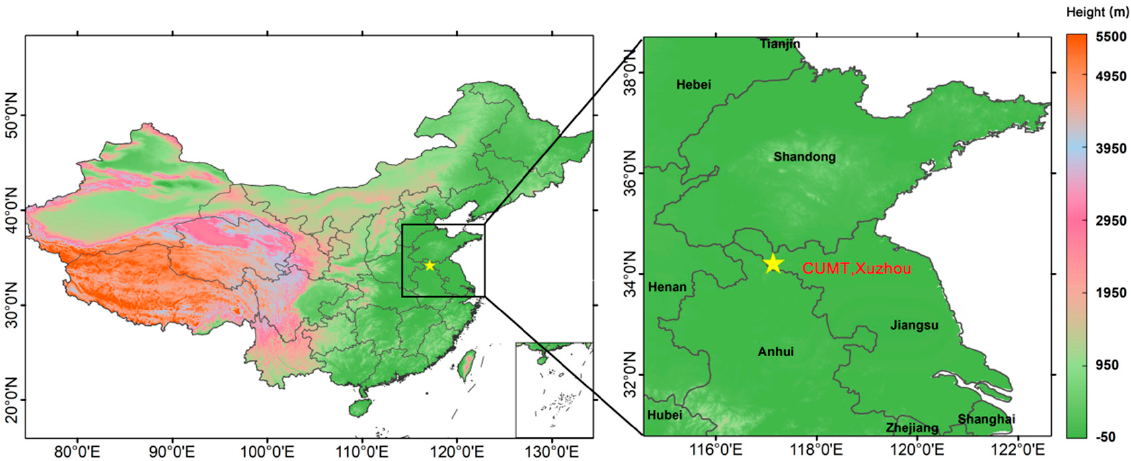
Figure 1. Elevation and location map of China University of Mining and Technology, Xuzhou, in China.